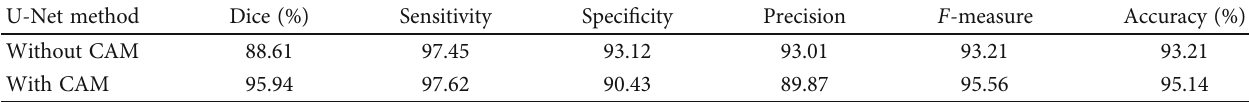
Table 5: U-Net method with/out CAM performance.